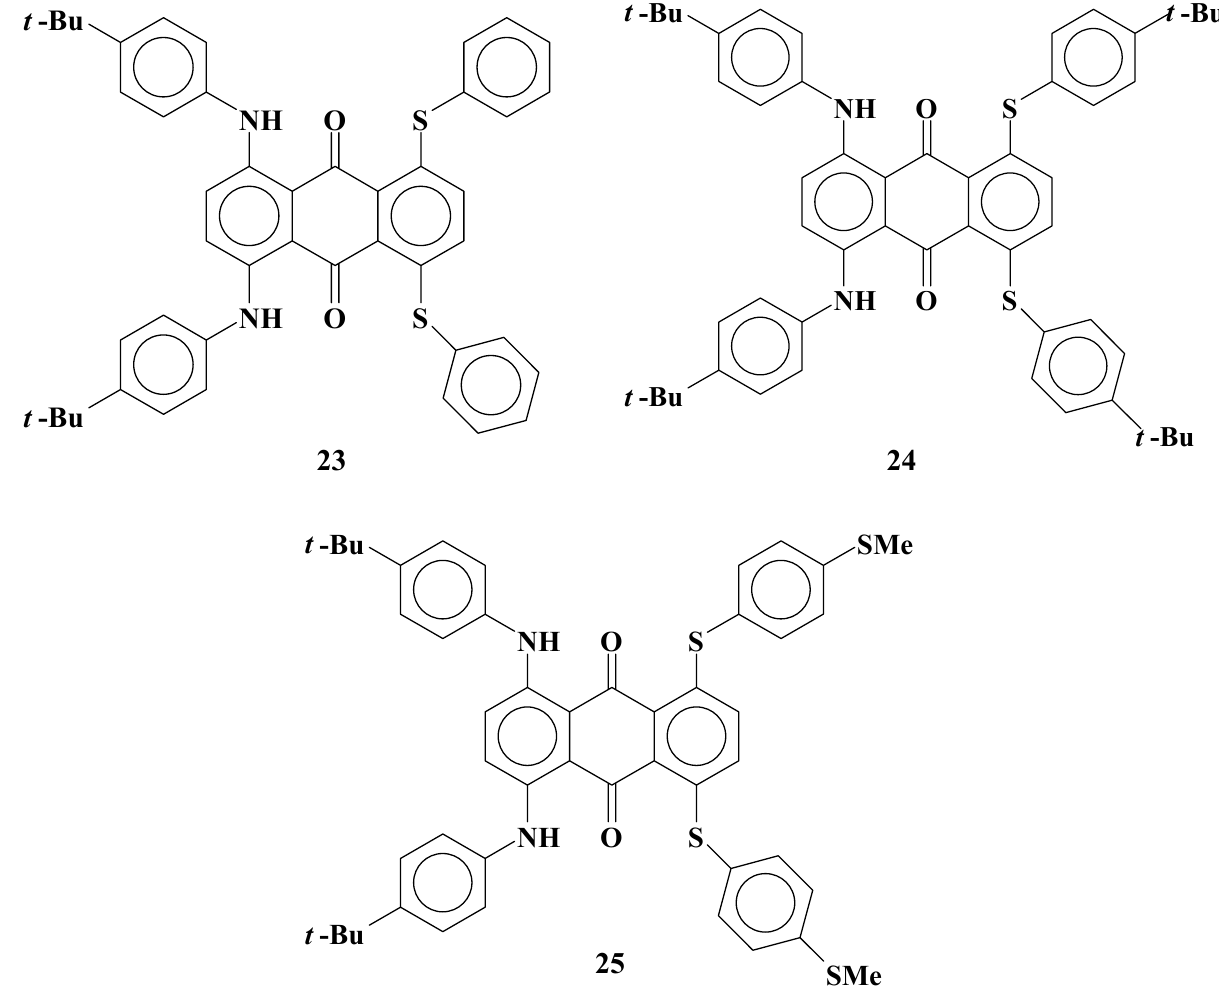
Figure 14. The molecular structures of cyan anthraquinone dyes with two phenylthio groups and two anilino groups.